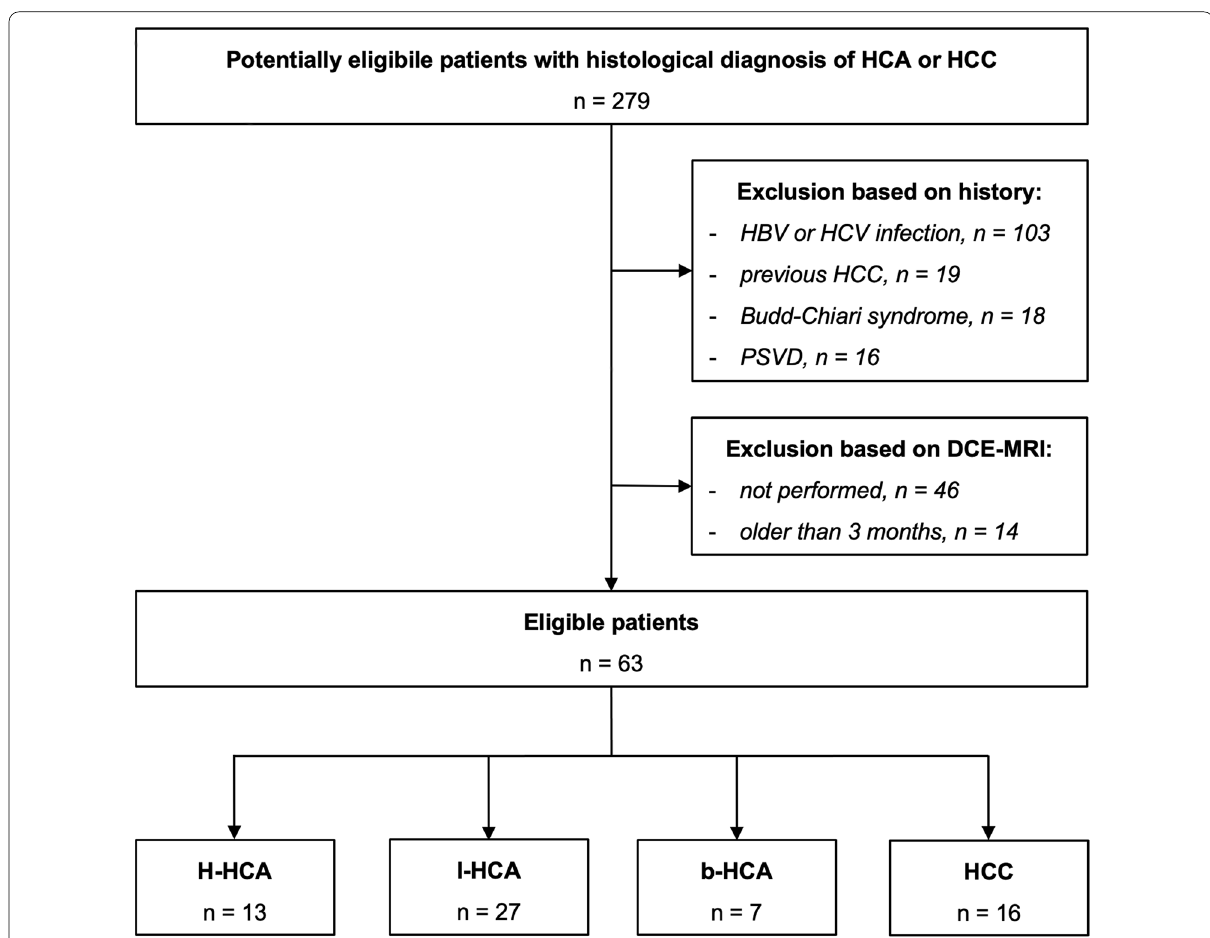
Fig. 1 Flowchart of retrospective patient inclusion. HCA—hepatocellular adenoma, HCC—hepatocellular carcinoma, HBV/HCV—hepatitis B or C virus, PSVD—porto-sinusoidal venous disease, DCE-MRI—dynamic contrast-enhanced magnetic resonance imaging, H-HCA—HNF1α-inactivated HCA, b-HCA—β-catenin-exon-3-mutated HCA, I-HCA—inflammatory